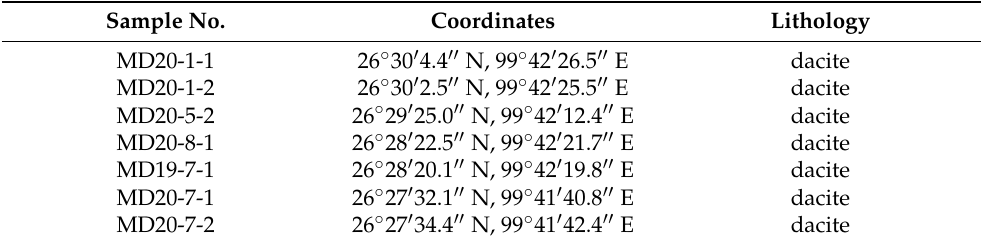
Table 1. Summary of samples from Madeng